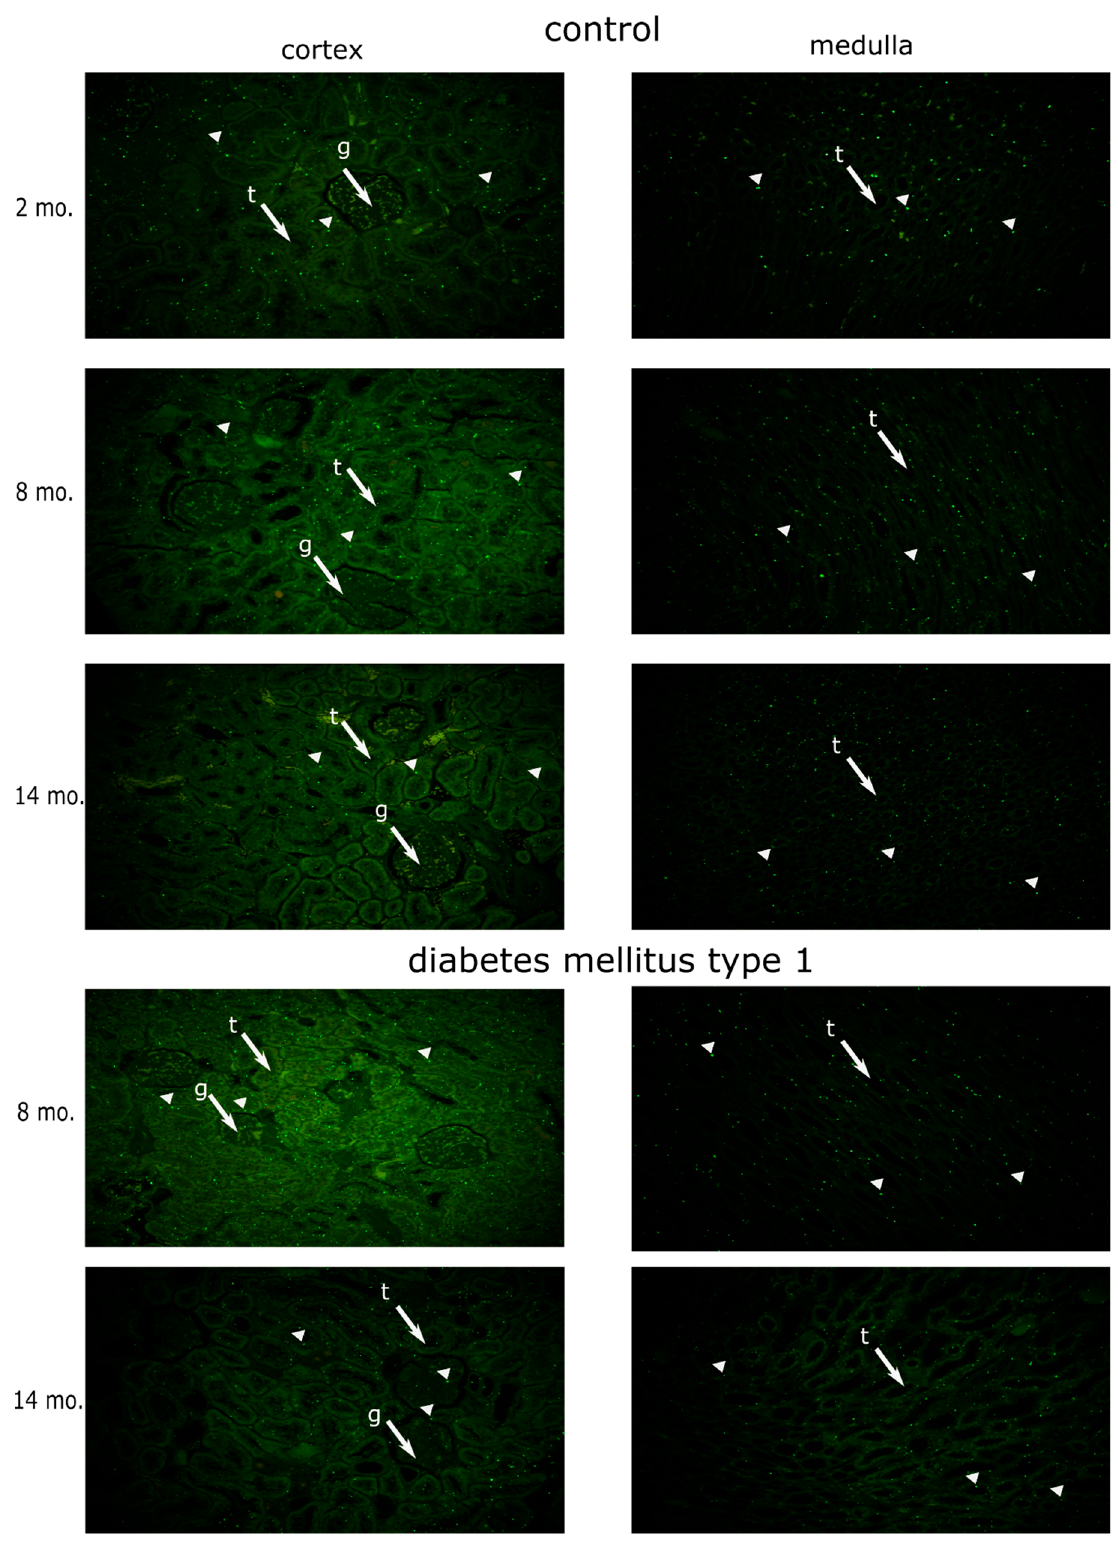
Figure 1. Representative microphotograph of MSH2 staining for each tissue compartment and timepoint in healthy and diabetic rats (200× magnification). Legend: g with arrow—glomerulus, t with arrow—tubulus, arrowhead—positive fluorescent signal for MSH2.